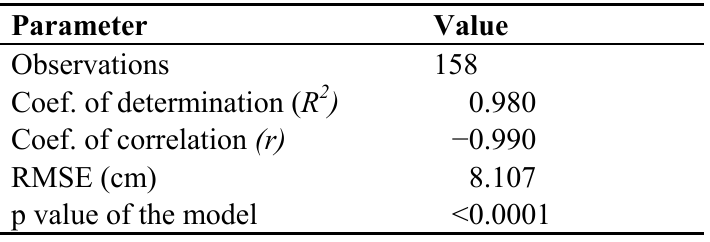
Table 4. Summary of the fitted linear model to estimate distances to the first leaf from the sensor output in field conditions.